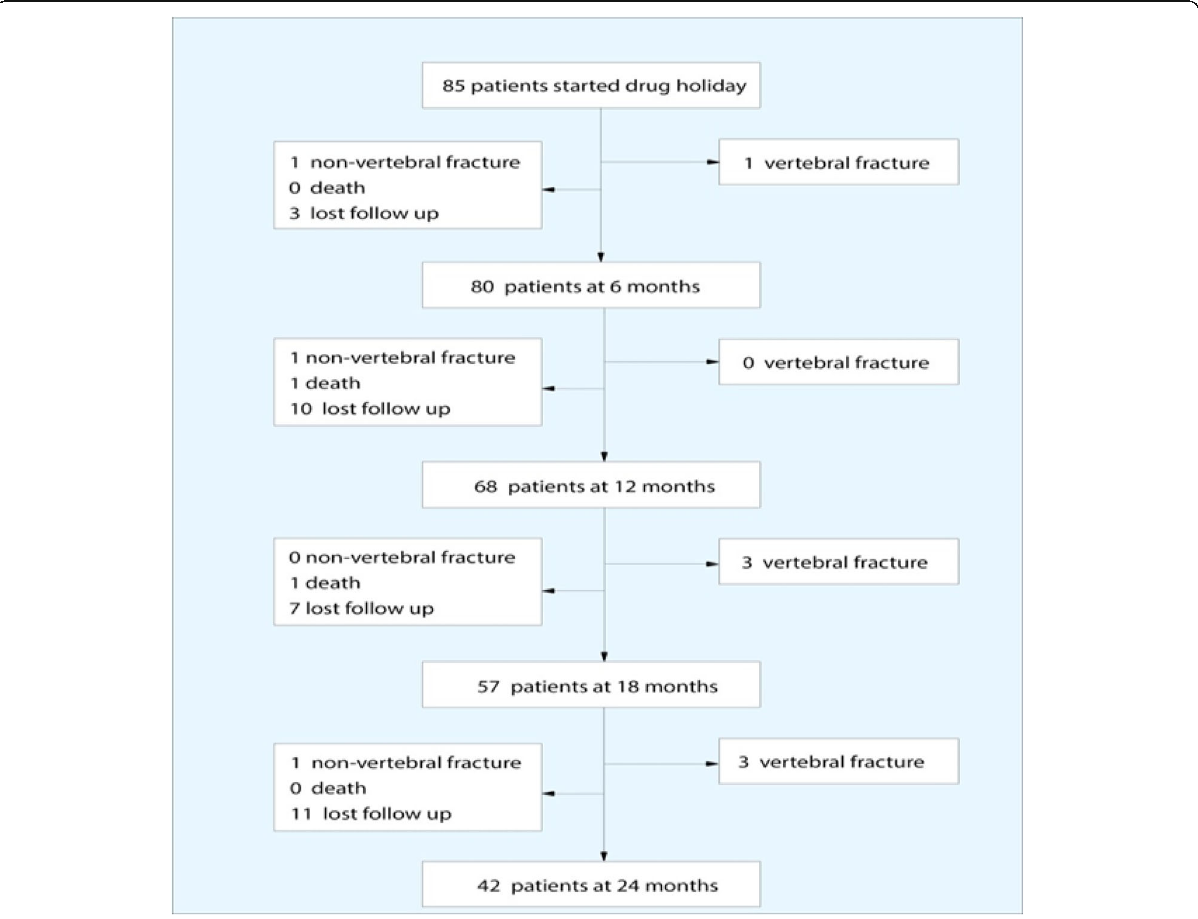
Fig. 1 Flowchart of the